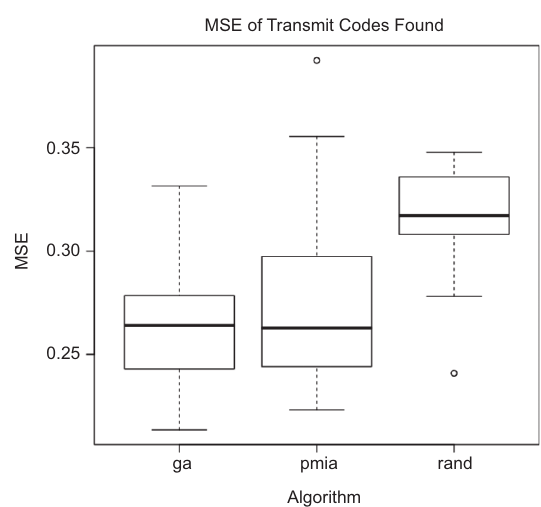
Figure 2. Length 52 2 PSK Box Plot Results.